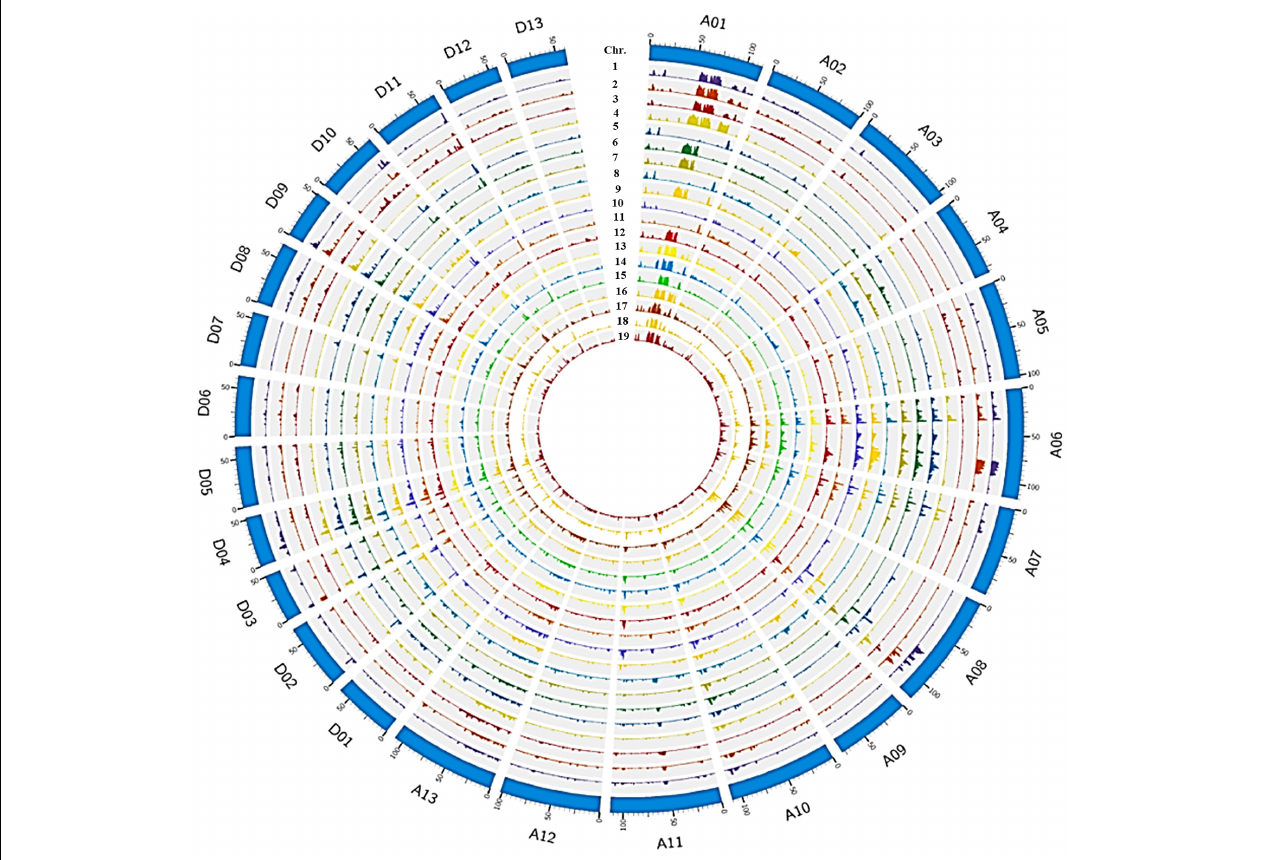
FIGURE 1 | Genome wide SNP distribution across 26 chromosomes of 19 Sea Island cotton accessions in the JH1-derived pedigree. The outermost layer represents the 26 chromosomes (A01–13 to D01–13) in a clockwise direction, then from the second outside circle inward, the layers show SNP density in